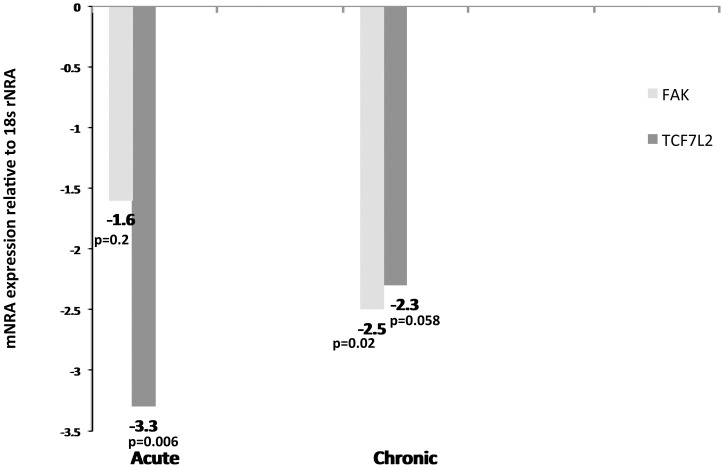
FAK and TCF7L2 expression is significantly decreased in the intestinal epithelium during acute and chronic SIV infection.Relative abundance in gene expression for FAK (light bars) and TCF7L2 (dark bars) in the intestinal epithelial cellular compartment of the jejunum at 21DPI (n = 4) and 6 months (n = 6) post SIV infection detected using quantitative real-time SYBR green two-step RT-PCR. The fold differences in gene expression were calculated as described in Materials and Methods. The relative fold increase is shown adjacent to each bar graph. The asterisk (*) indicates statistical significance (p<0.05).